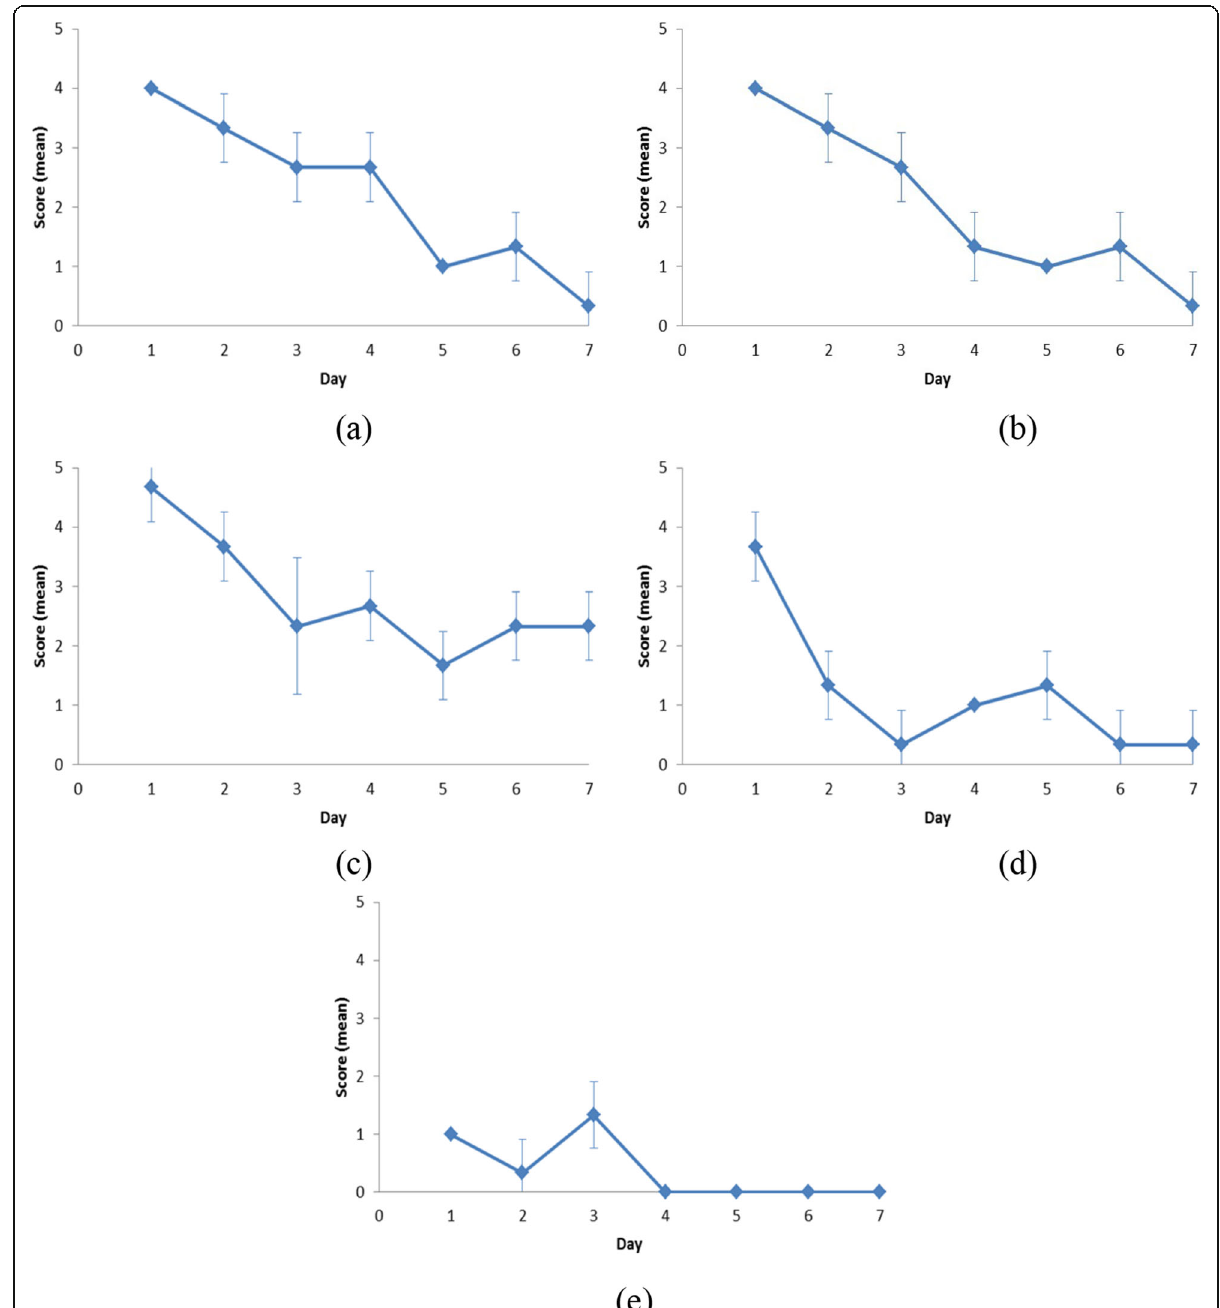
Fig. 12 The quality of developed fingermarks based on the visibility score using a powder dusting, b small particle reagent, c Sudan black, d oil red O, and e crystal